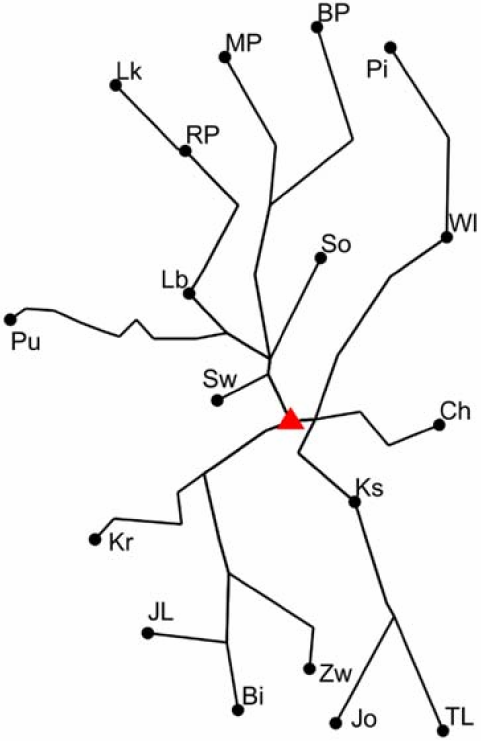
Figure 5. The minimum cost tree rooted in optimal